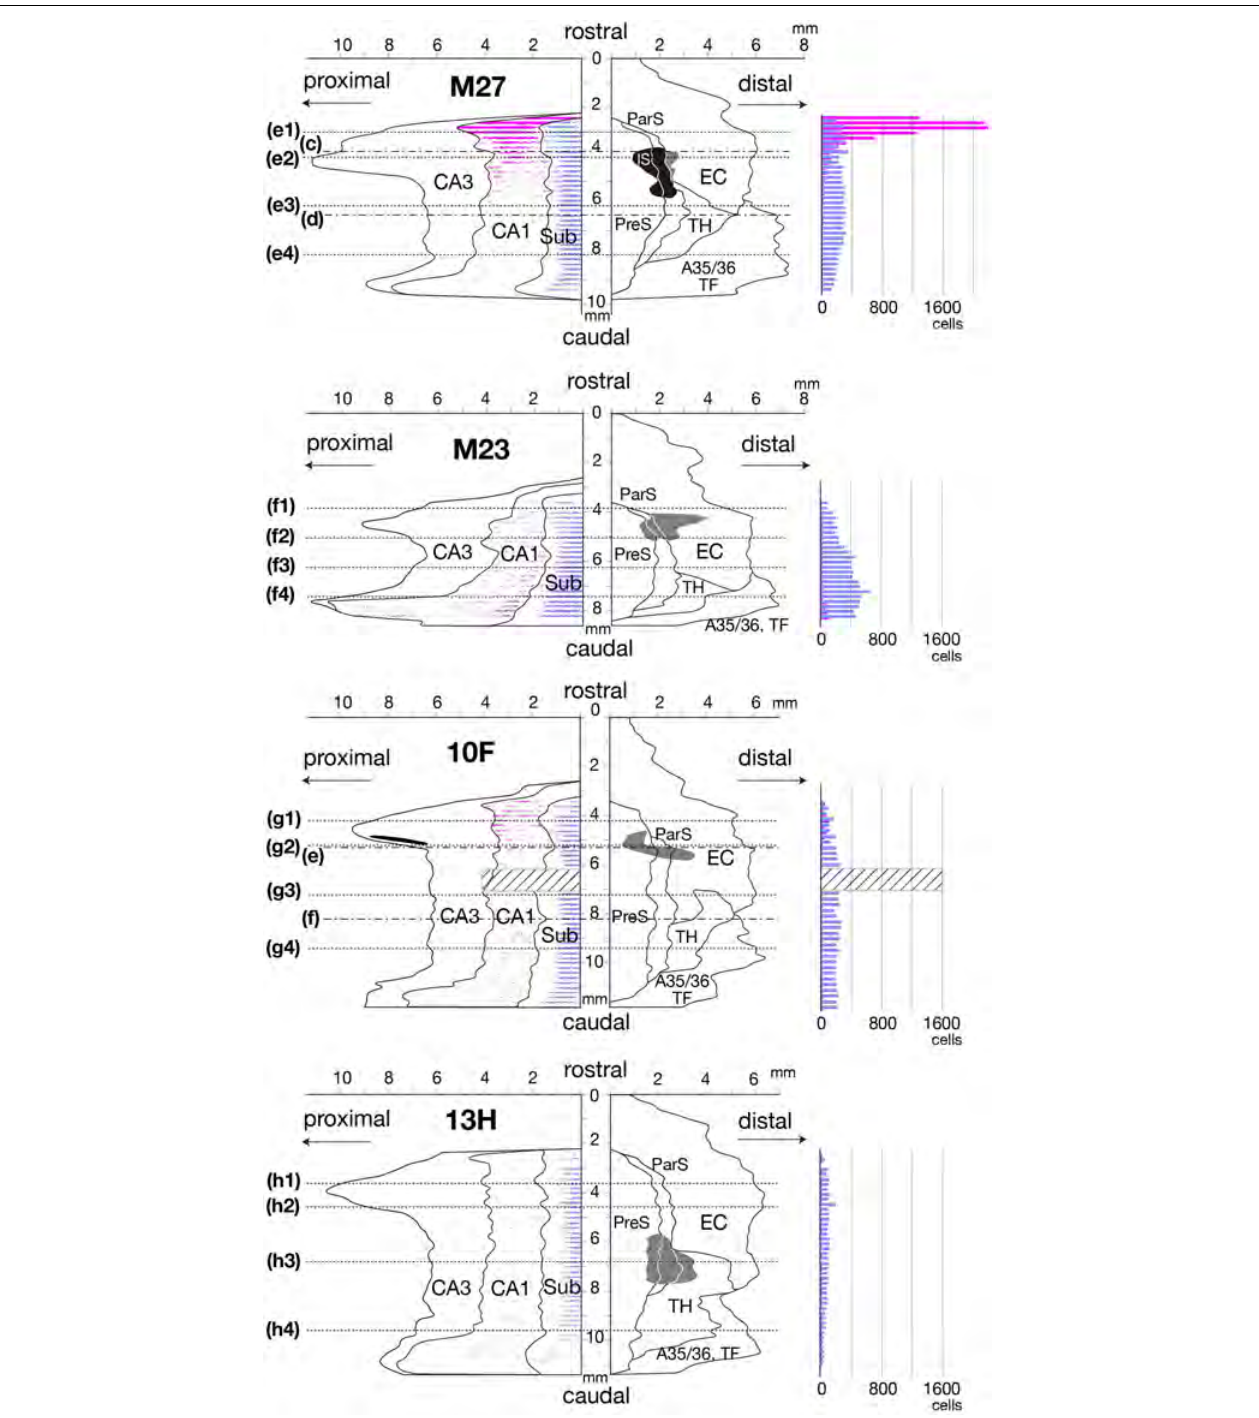
FIGURE 2 | Distributions of CTB injection sites and density of distributions of retrogradely labeled cells in CA1 and Sub are represented on a two-dimensional unfolded map and histogram of each case. Left unfolded maps: Black regions indicate CTB injection sites that extended to all layers. The gray regions in cases 09E, M27, M23, 10F, and 13H indicate the injection sites that was restricted to the superficial layers, and the shaded-gray region in case 09D indicates the injection site of EC that was restricted to the deep layers. Magenta- and blue-filled regions in cases M25 and 09D indicate the portions that overlapped with the center of diffusion of the injection site and plotting of the labeled cells was partially difficult within these regions. Magenta dots and blue dots indicate the distribution of single retrogradely labeled cells in CA1 and Sub, respectively. Dotted lines of each unfolded map indicate the rostrocaudal level of each section in Figure 3 . Alternate